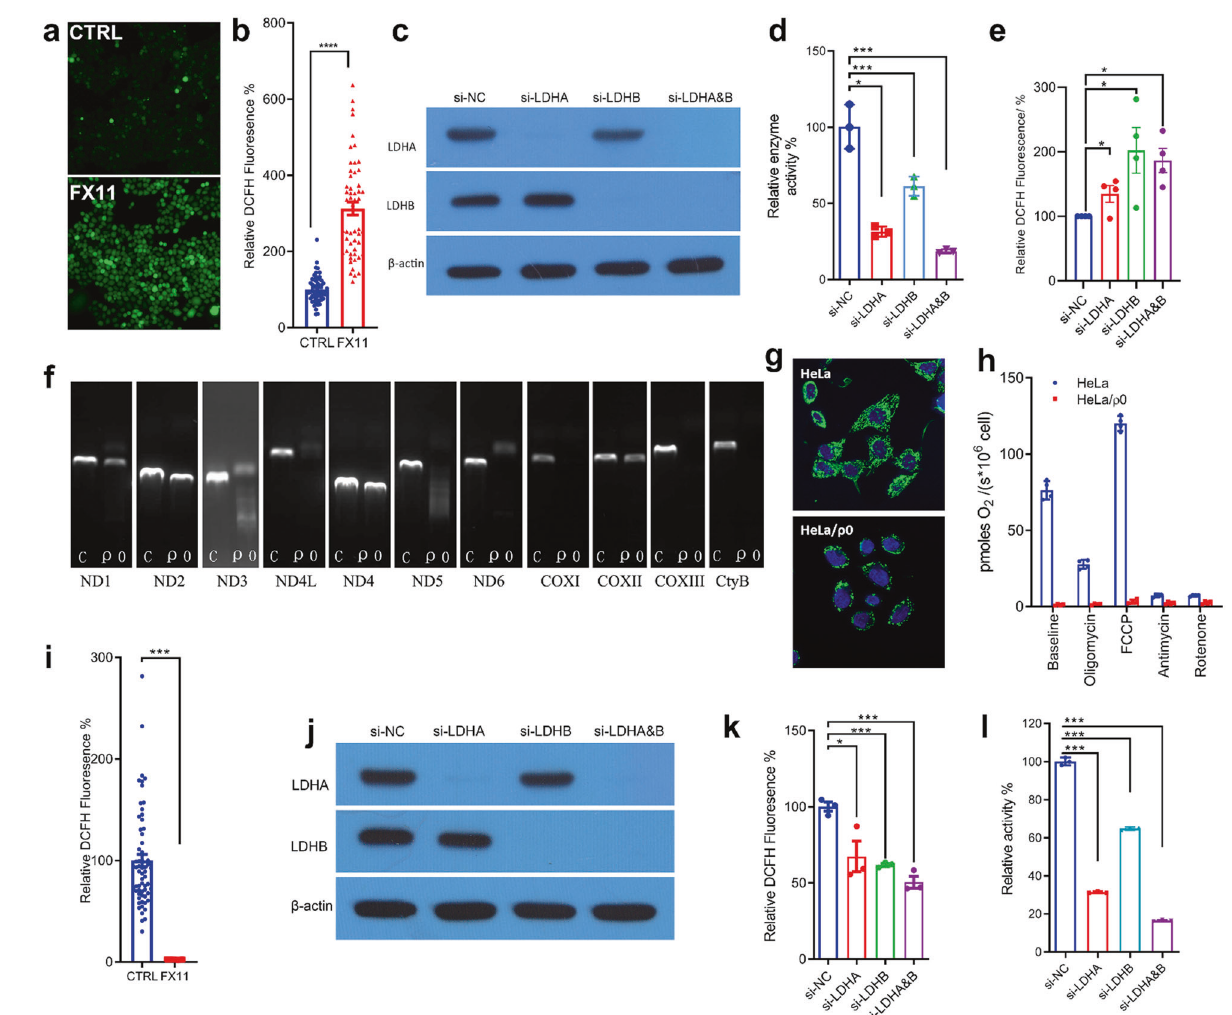
Fig. 3 The antioxidative activity of LDH in HeLa cells and the pro-oxidative activity of LDH in HeLa/ ρ 0 cells. a , b LDH inhibitor FX11 increases total cellular ROS level. HeLa cells were treated with or without 15 µM FX11 for 30 min and loaded with 10 µM DCFH-DA. Fluorescence signal was recorded by microscope imaging ( a ) and total signal of each cells was calculated for analysis ( b ). c Western Blot of LDHA and LDHB of the cell lysate prepared from siRNA transfected HeLa cells. HeLa/si-NC, negative control; HeLa/si-LDHA, LDHA knockdown cell; HeLa/si-LDHB cells, LDHB knockdown cell; HeLa/si-LDHA&B, LDHA and LDHB double knockdown cell. d Speci fi c enzyme activity of the cell lysate prepared from HeLa/si-NC, HeLa/si-LDHA, HeLa/si-LDHB, and HeLa/si-LDHA&B cells. The speci fi c enzyme activity refers the one that converts pyruvate to lactate. e The total cellular ROS level probed by DCFH in HeLa/si-NC, HeLa/si-LDHA, HeLa/si-LDHB, and HeLa/si-LDHA&B cells. f Electrophoresis of PCR products showed HeLa/ ρ 0 cells lacked mitochondrial DNA (mtDNA)-coded genes, which are essential for ETC complexes. g HeLa/ ρ 0 cells had less mitochondria mass compared with parental HeLa cell. Cells were stained with MitoTraker Green, a Mitochondrion-selective probe, and imaged under confocal microscope. h Oxygen consumption rate (OCR) in HeLa cells and HeLa/ ρ 0 cells. i LDH inhibitor FX11 reduces total ROS level in mitochondrial DNA de fi cient HeLa/ ρ 0 cells, probed by DCFH. j Western blot con fi rmation of LDHA or LDHB knockdown in HeLa/ ρ 0 cells by siRNA. k Knockdown of LDH isoforms signi fi cantly decreases the total cellular ROS level in HeLa/ ρ 0 cells. l LDH knockdown decreased speci fi c activity of LDH in HeLa/ ρ 0 cells. Data were con fi rmed by at least three independent experiments. The experimental details are described in Materials and